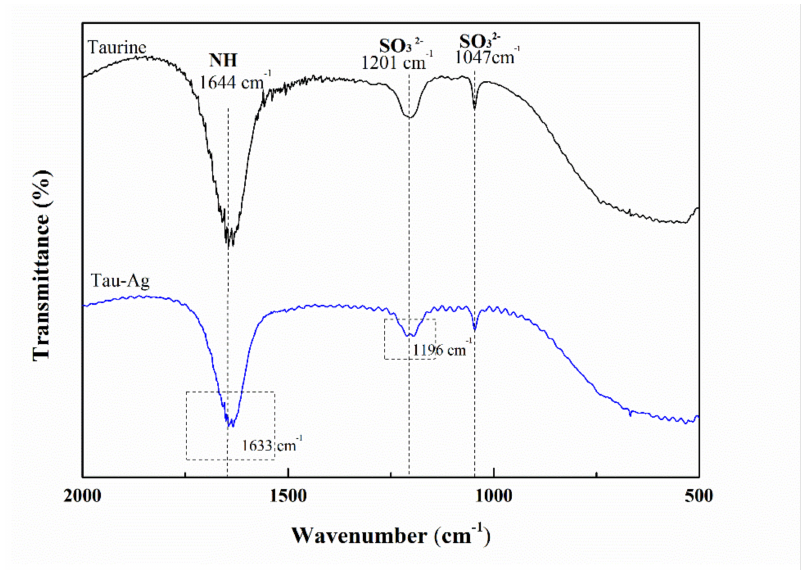
Figure 4. FTIR spectra of taurine and